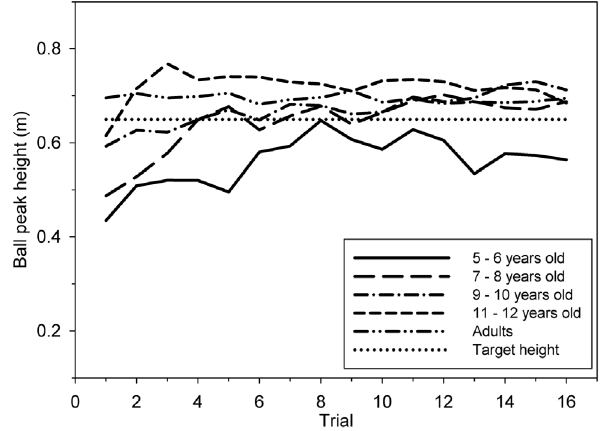
Figure 2. Mean ball peak height h p throughout 16 trials for the 5 age groups.